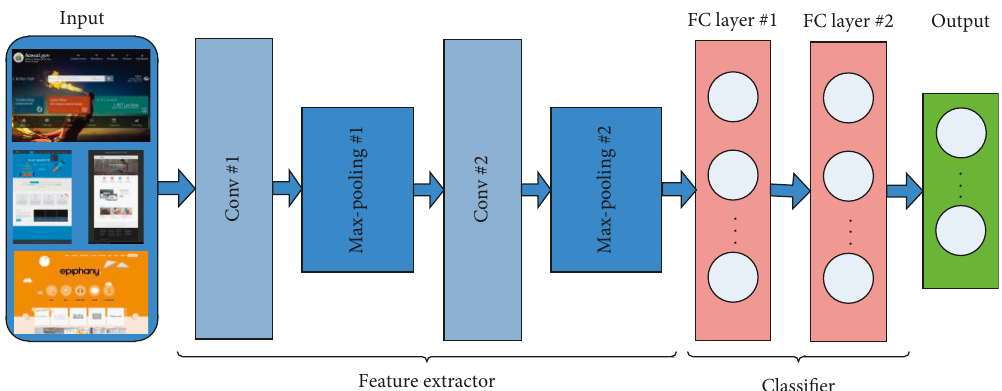
Figure 2: Structure of the flat website design element identification system.